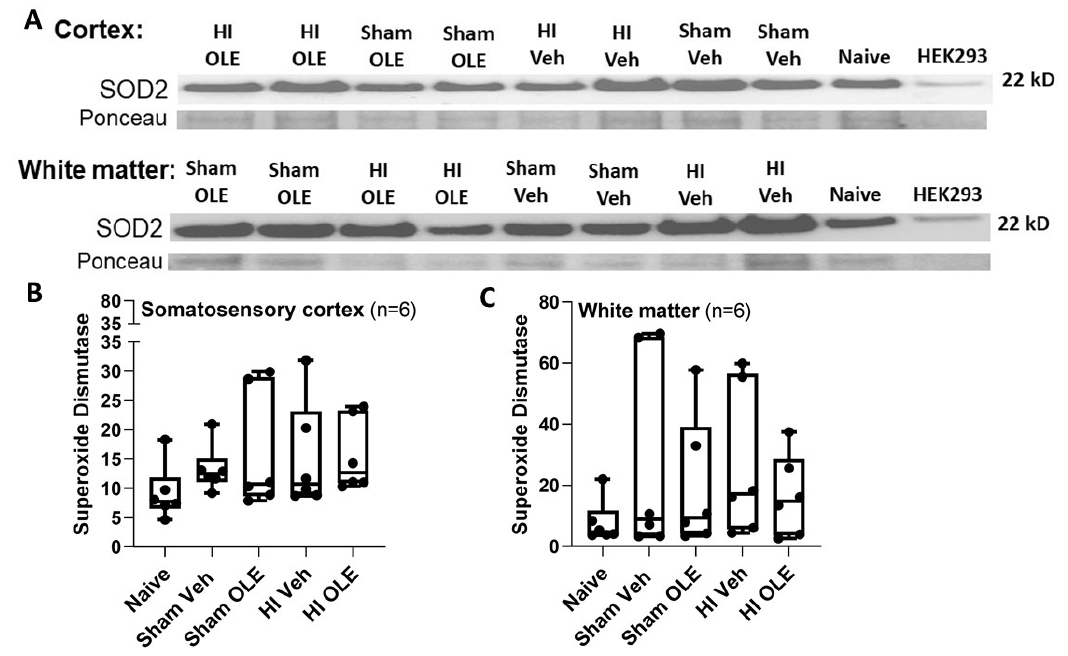
Figure 13. Western blots for manganese superoxide dismutase (SOD2) immunoreactivity in somatosensory cortex and white matter of piglets that received hypoxia-ischemia (HI) or sham procedure with oleuropein (OLE) or vehicle (veh, A ). SOD2 levels did not differ in the cortex ( p = 0.125, B ) or in white matter ( p = 0.609, C ). The box plot whiskers show the 5th and 95th percentiles.